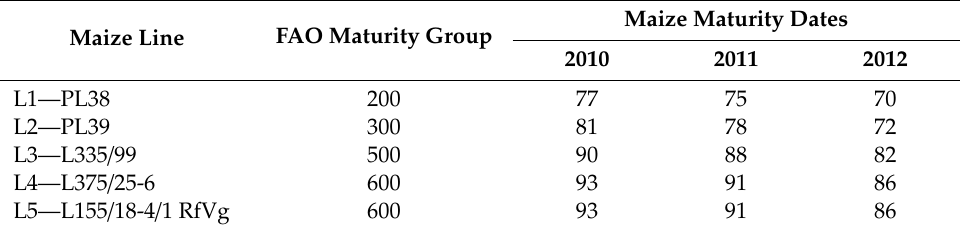
Table 1. Maize lines, FAO maturity group, and maturity dates for each experimental year. Maize Line